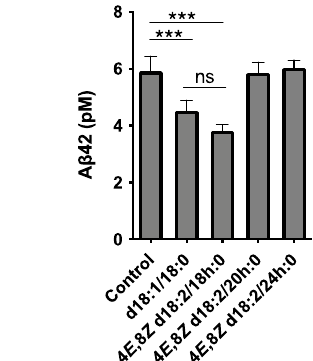
Figure 4. The levels of A β 40 and Aß42 in medium from Transwell cultured APP-expressing SH-SY5Y and BV-2 cells. After 24 h of the indicated Cers treatment, A β levels in culture media were determined. Values are the means ± SD. ( n = 3, * p < 0.05; *** p < 0.001 by one-way ANOVA).